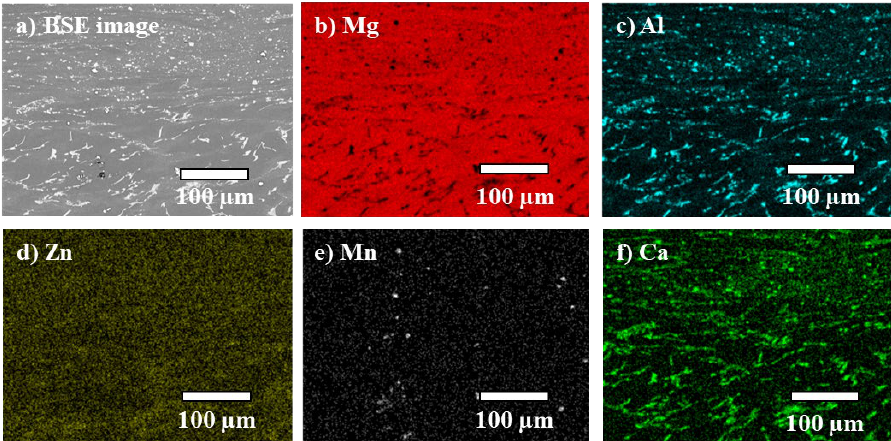
Figure 9. ( a ) AZ91–2Ca/AZ91–2Ca weld. ( b – e ) EDS elemental mapping of the weld region between the base material (bottom) and the central weld zone (top). Al ( c ) is seen in the Al 2 Ca particles, while Zn ( d ) appears to be dispersed in the matrix. Mn ( e ) remained in the Al 8 Mn 5 phase. Towards the weld region, Ca ( f ) predominates in the smaller